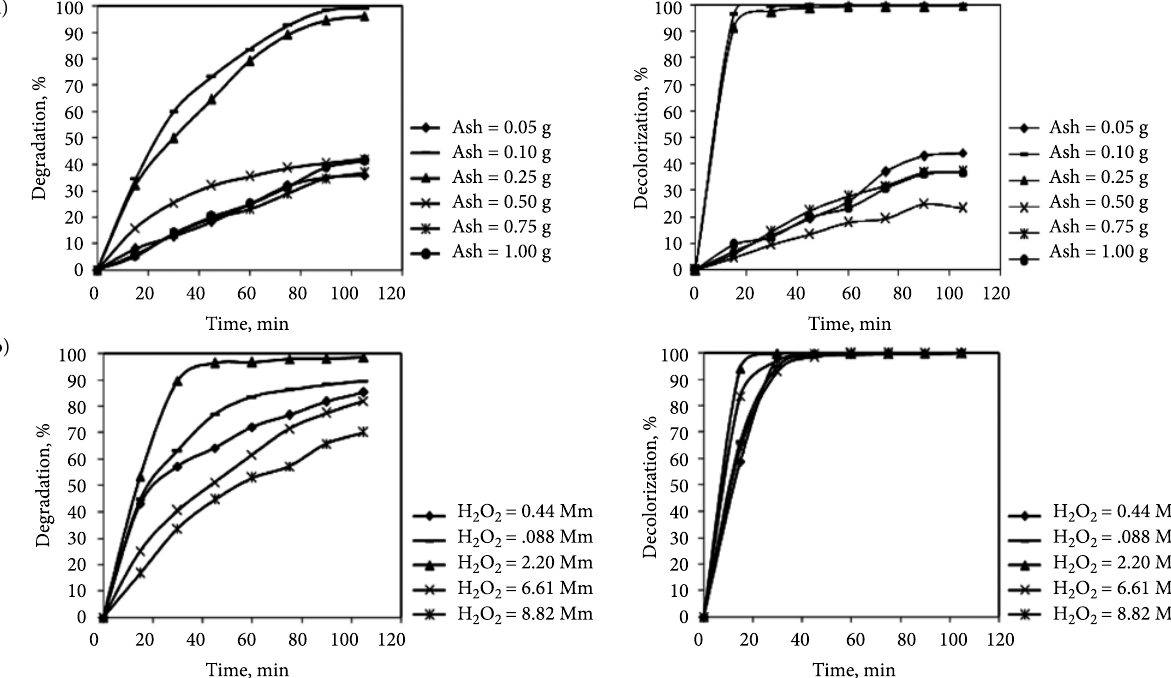
Fig. 8. Percentage degradation and decolourization of RB5 at (a) varying concentration of FA (b) varying concentration of H